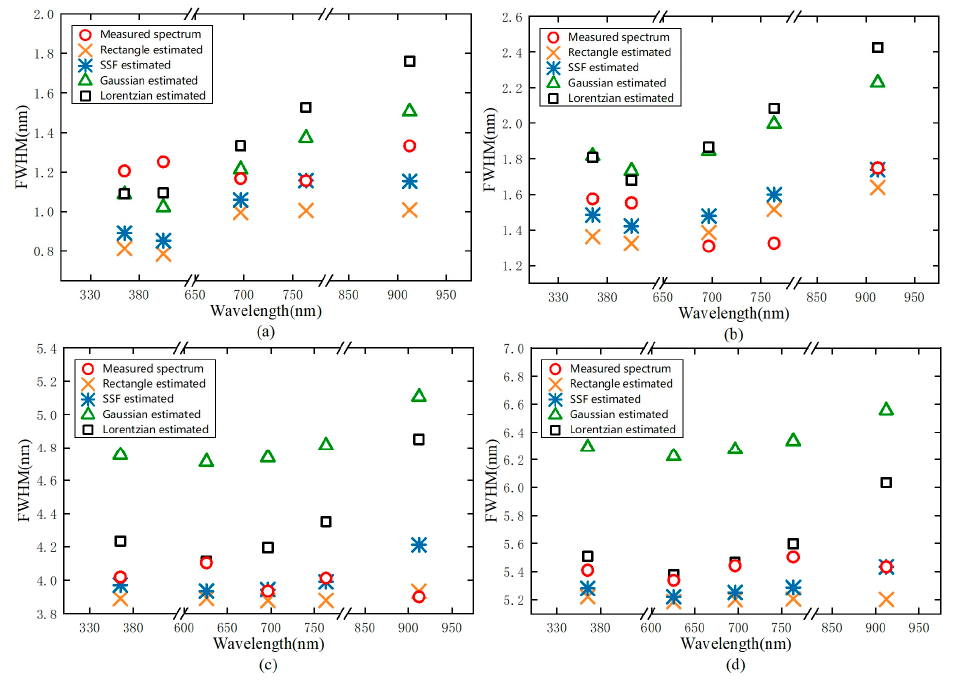
Figure 3. Wavelength resolutions at slits widths of ( a ) 25 µ m, ( b ) 50 µ m, ( c ) 150 µ m, and ( d ) 200 µ m. The circle represents the measured spectrum, and the cross, asterisk, triangle, and square represent the estimation results of rectangle function, convolution of SSF with rectangle function, Gaussian function, and Lorentzian function, respectively.